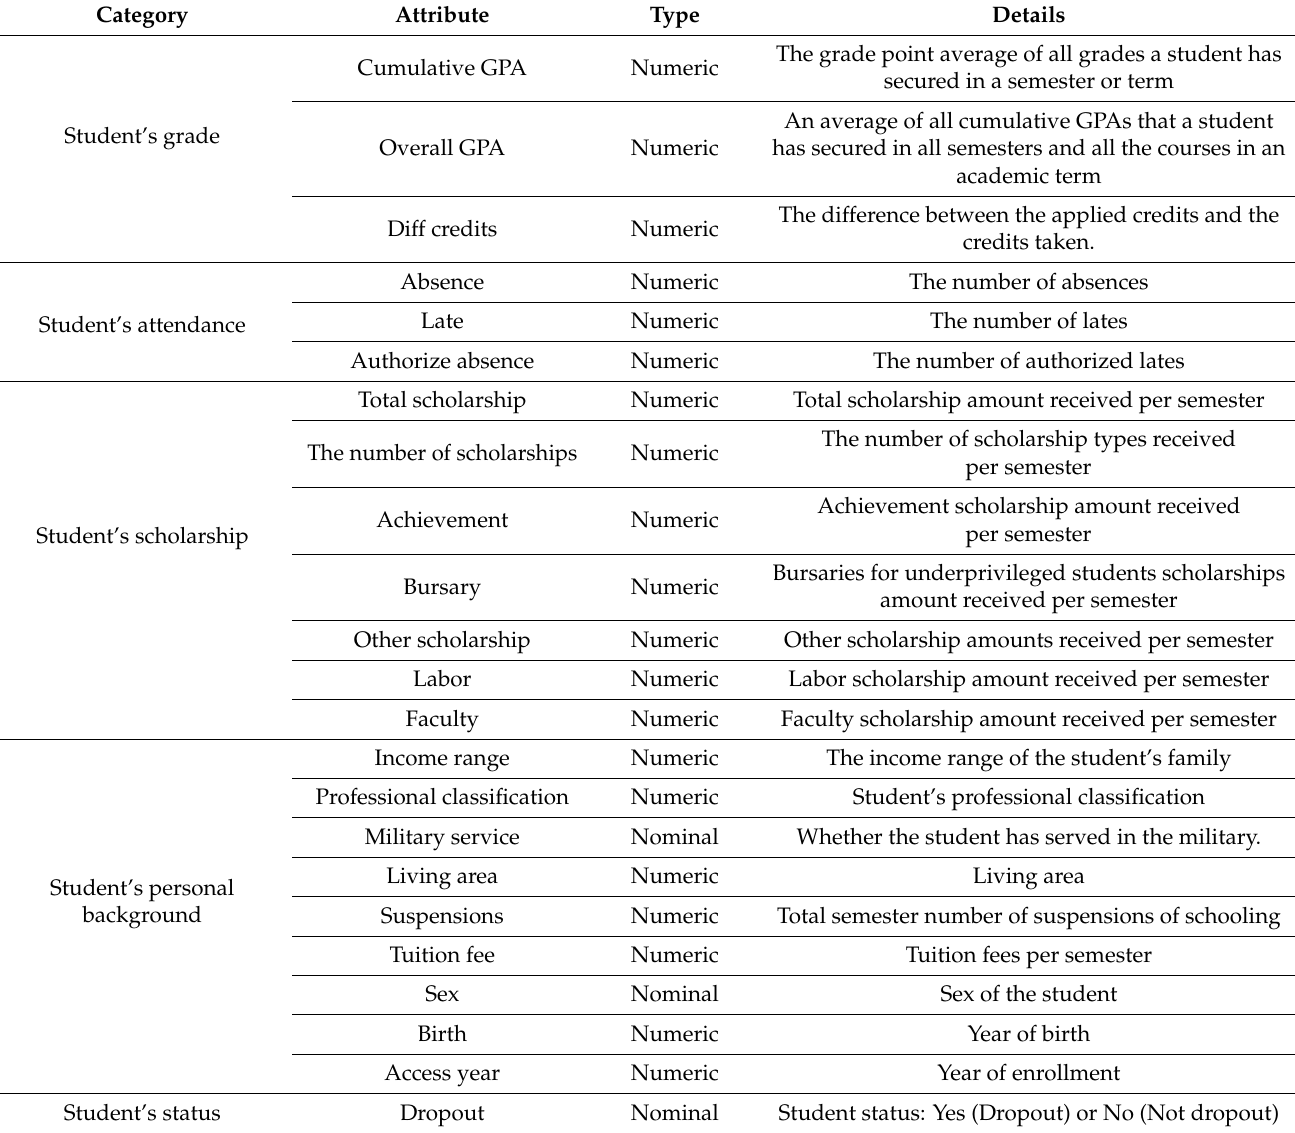
Table 2. Feature Table from Student Data.